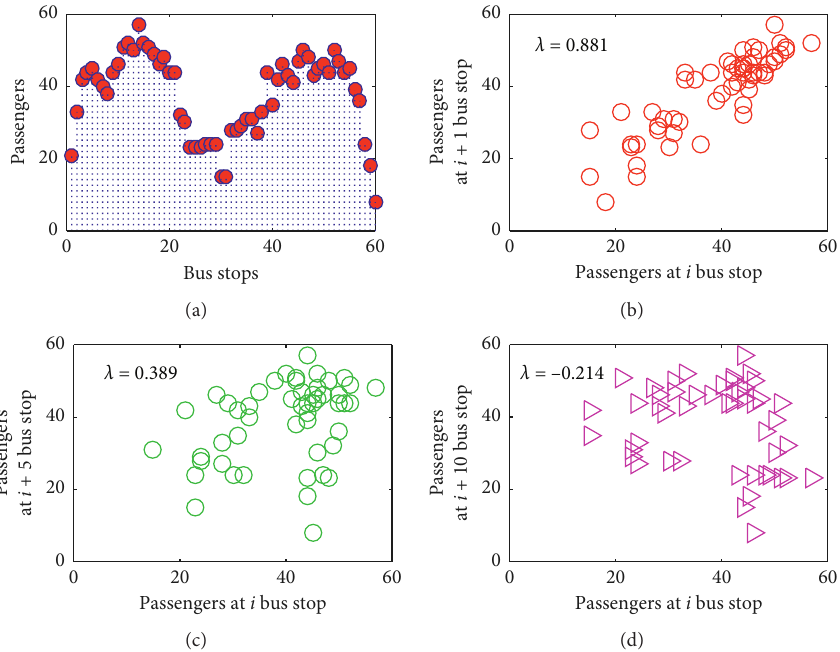
Figure 13: Measured passenger data and the correlation analysis for peak hours. (a) Measured data. (b) 1-step transition. (c) 5-step transition. (d) 10-step transition.